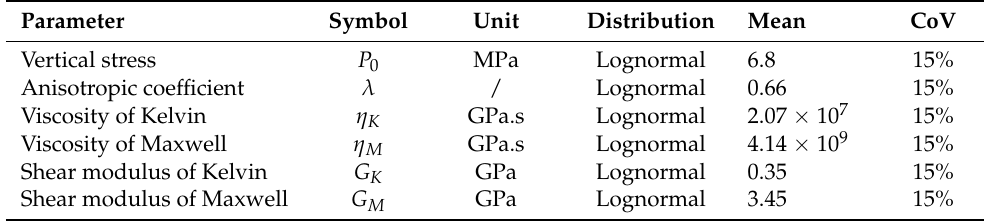
Table 2. Uncertainty modelling of the Burger and initial-stress parameters.